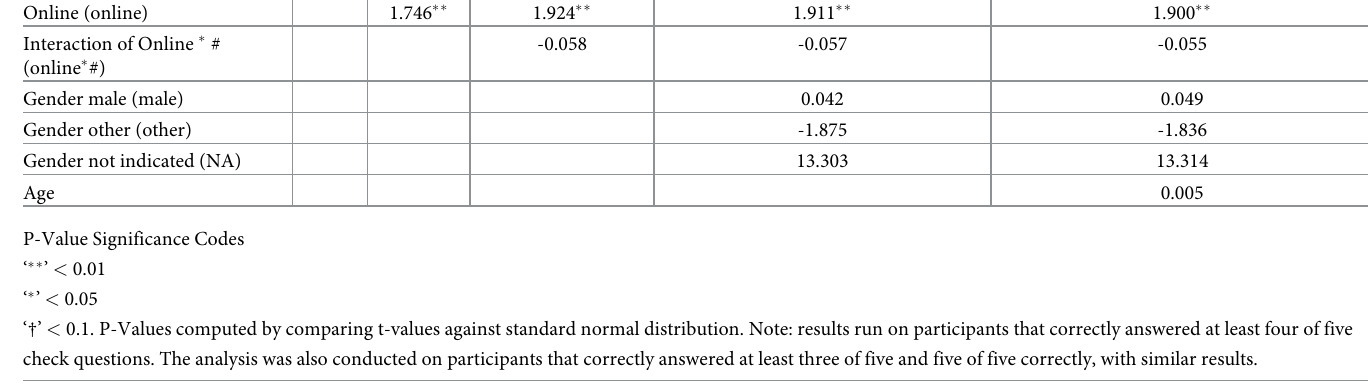
(Table 14) and Linear Regression (Table 15) with a step-wise addition of each variable in our final model: # of items at the second store, a dummy variable for Online vs. Offline presenta- tion (Online), Gender, and Age. R base version 3.4.2 was utilized with ordered logistic regres- sion performed using the polr function of the MASS package version 7.3–47 and linear regression performed using the stats package of the base R version. Both types of regression analysis support H3 (Quantity Bias), H5 (Quantity-Online), and H6 (Quantity-Online Offline-Items) with controls Age and Gender not becoming significant